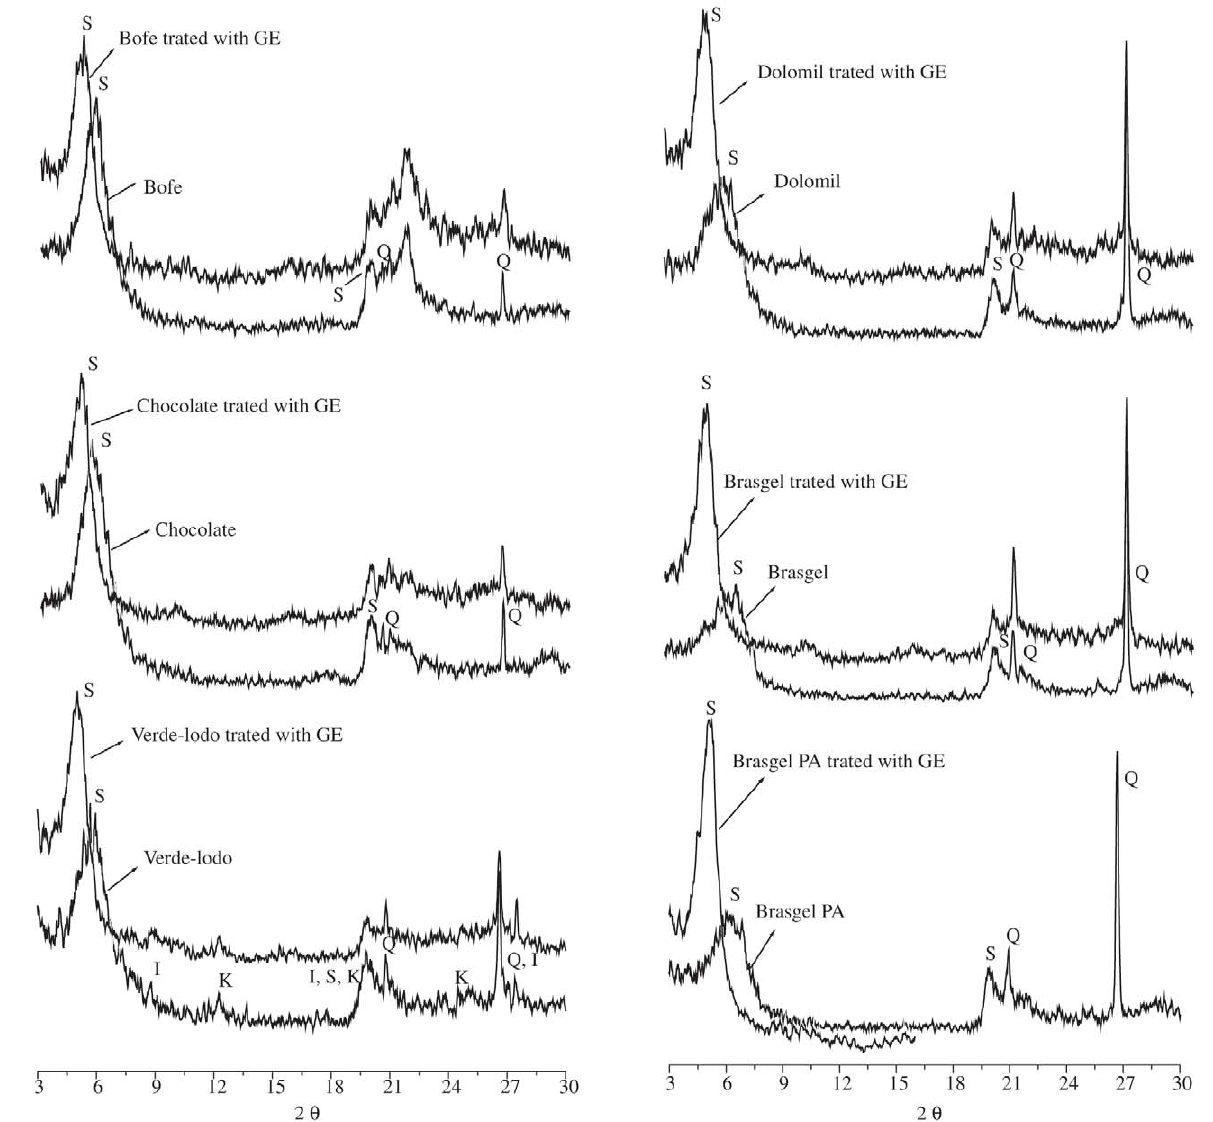
Figure 3. X-ray diffractions patterns for the bentonite samples: a) Bofe ; b) Chocolate ; c) Verde-lodo ; d) Dolomil ; e) Brasgel; f) Brasgel PA